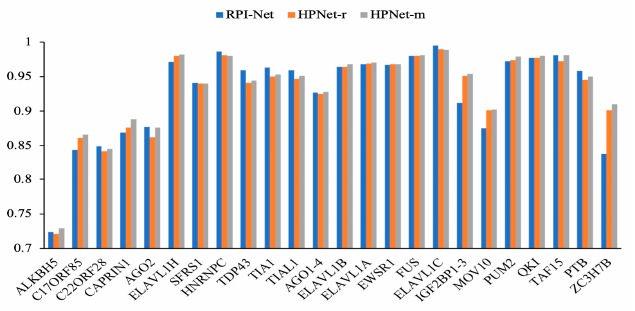
Table 3. Mean AUCs of three debiasing methods.